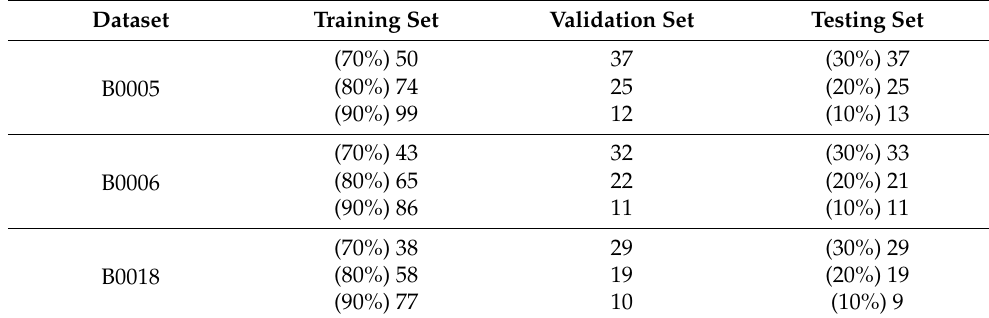
Table 2. Dataset segmentation.